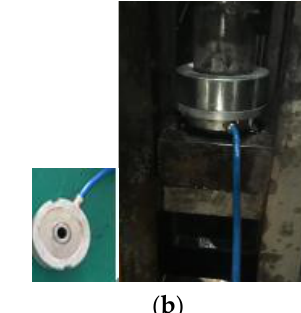
Figure 23. Installation situation. ( a ) General pressure sensor; ( b ) Particle damping sensor.